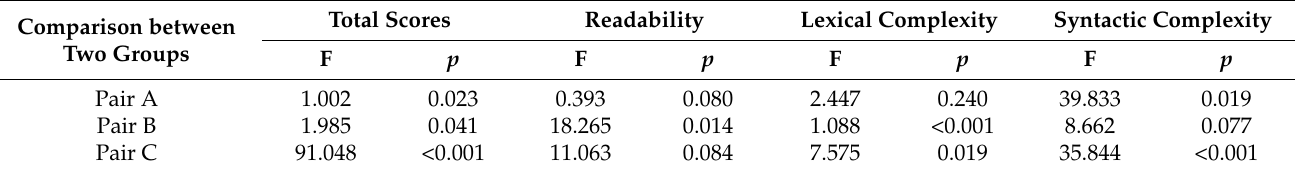
Table 5. Analysis of variance of score